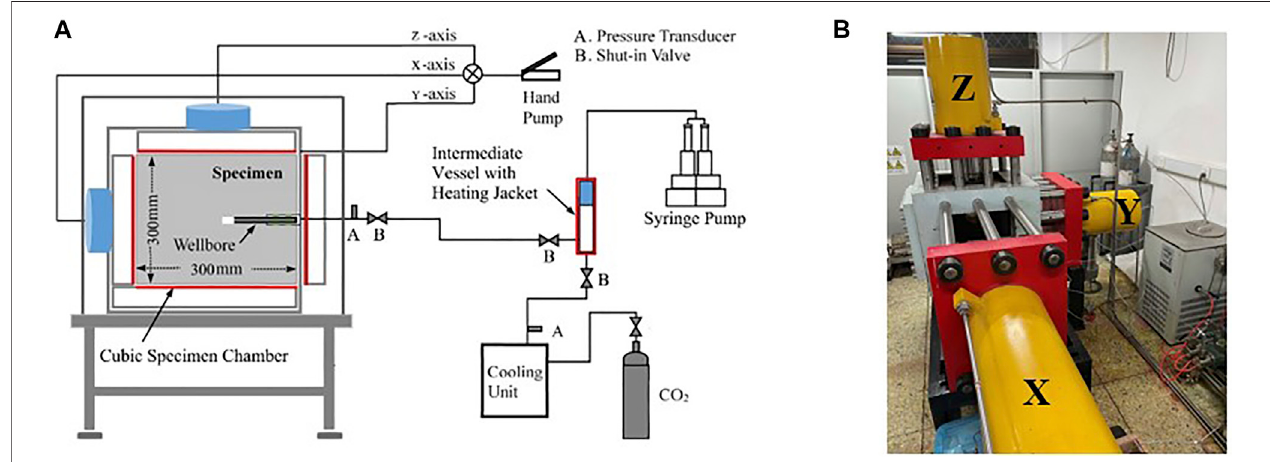
FIGURE 1 | The tri-axial fracturing system. (A) Sketch of the apparatus; (B) photo of the apparatus (Li et al., 2019b).